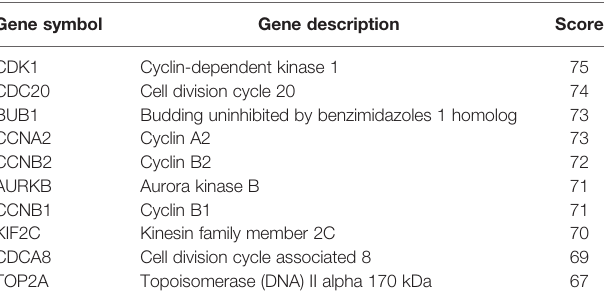
TABLE 2 | The top 10 hub genes in the protein-protein interaction (PPI) network ranked by degree method. Gene symbol